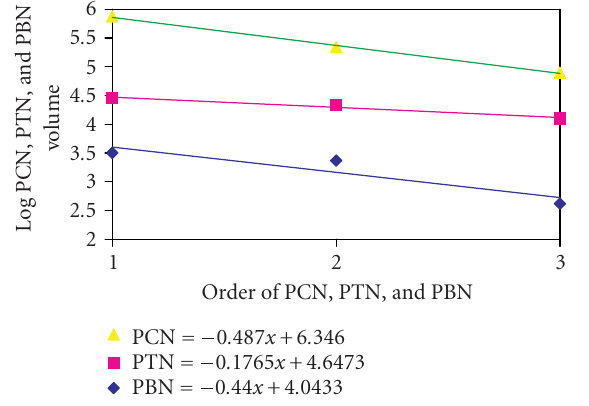
Figure 5.1. Distribution of pore-channel, -throat, and -body of fractal